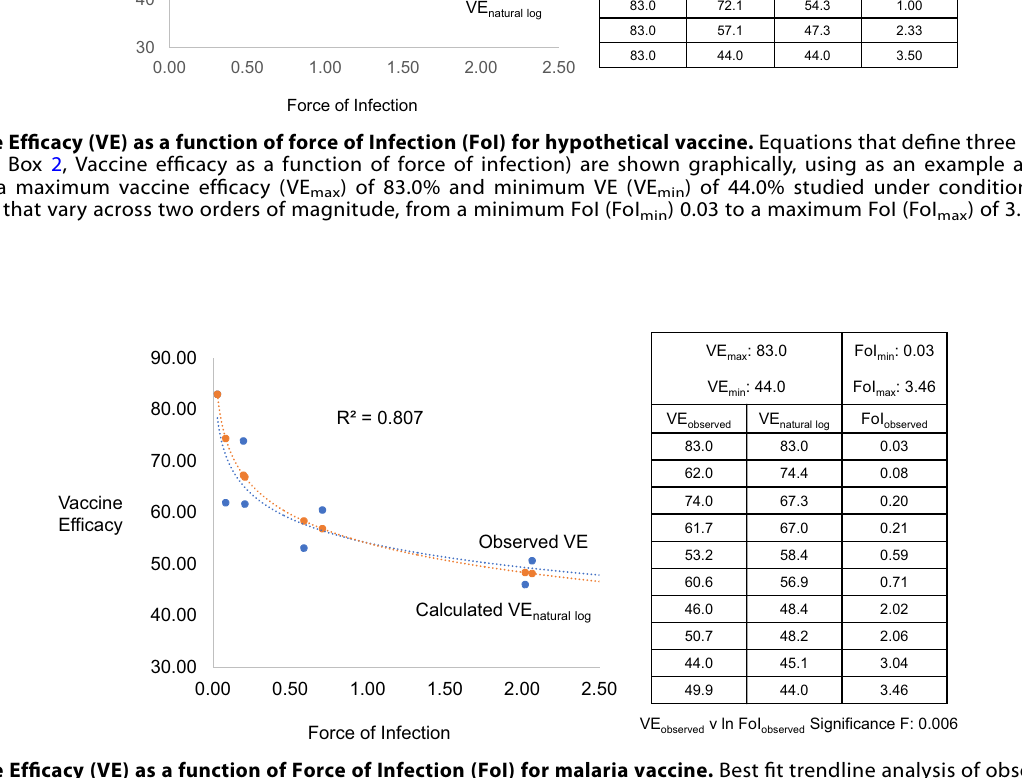
Fig. 2 Vaccine Ef fi cacy (VE) as a function of Force of Infection (FoI) for malaria vaccine. Best fi t trendline analysis of observed vaccine ef fi cacy (VE observed ) as a function of observed force of infection (FoI observed ) is shown as a logarithmic relationship (blue dotted line) with a R 2 of 0.807. A regression analysis of VE observed as a function of ln FoI observed shown in the embedded table has a Signi fi cance F of 0.006. Using the VE natural log equation (see Box 2, Vaccine ef fi cacy as a function of force of infection), the observed VE max , VE min , FoI max , FoI min , and FoI observed were used to calculate the VE natural log in the embedded table and the calculated VE natural log shown graphically (orange dotted line).